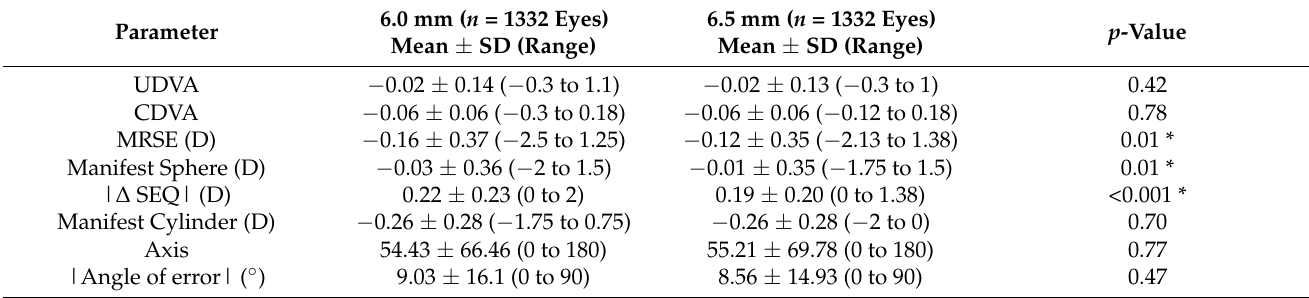
Table 2. Postoperative